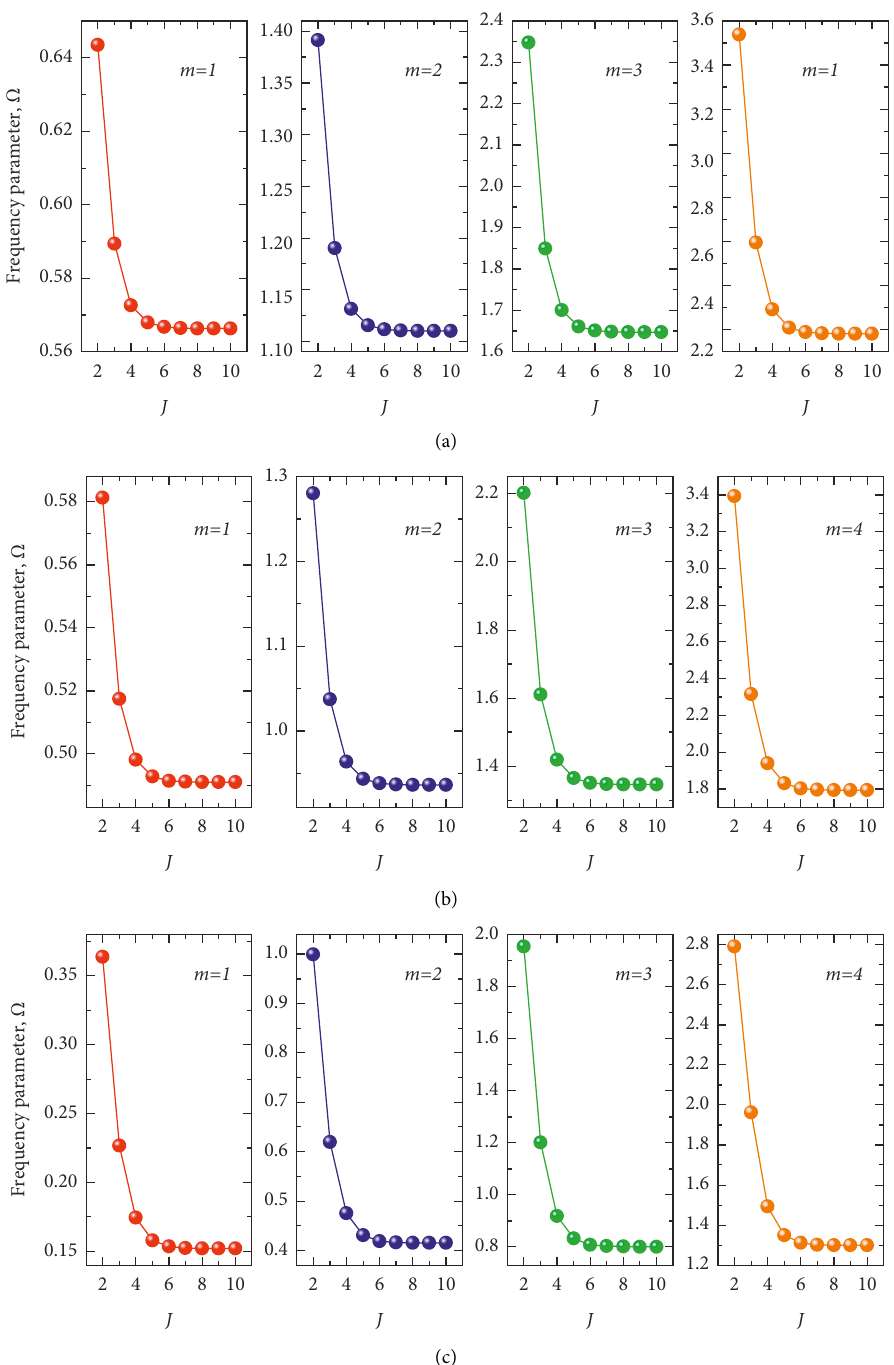
Figure 4: Convergence of frequency parameters Ω for the laminated composite structures with variable thickness and C–C boundary condition according to maximal level of resolution J ( n � 2), (a) conical shell, (b) cylindrical shell, and (c) annular